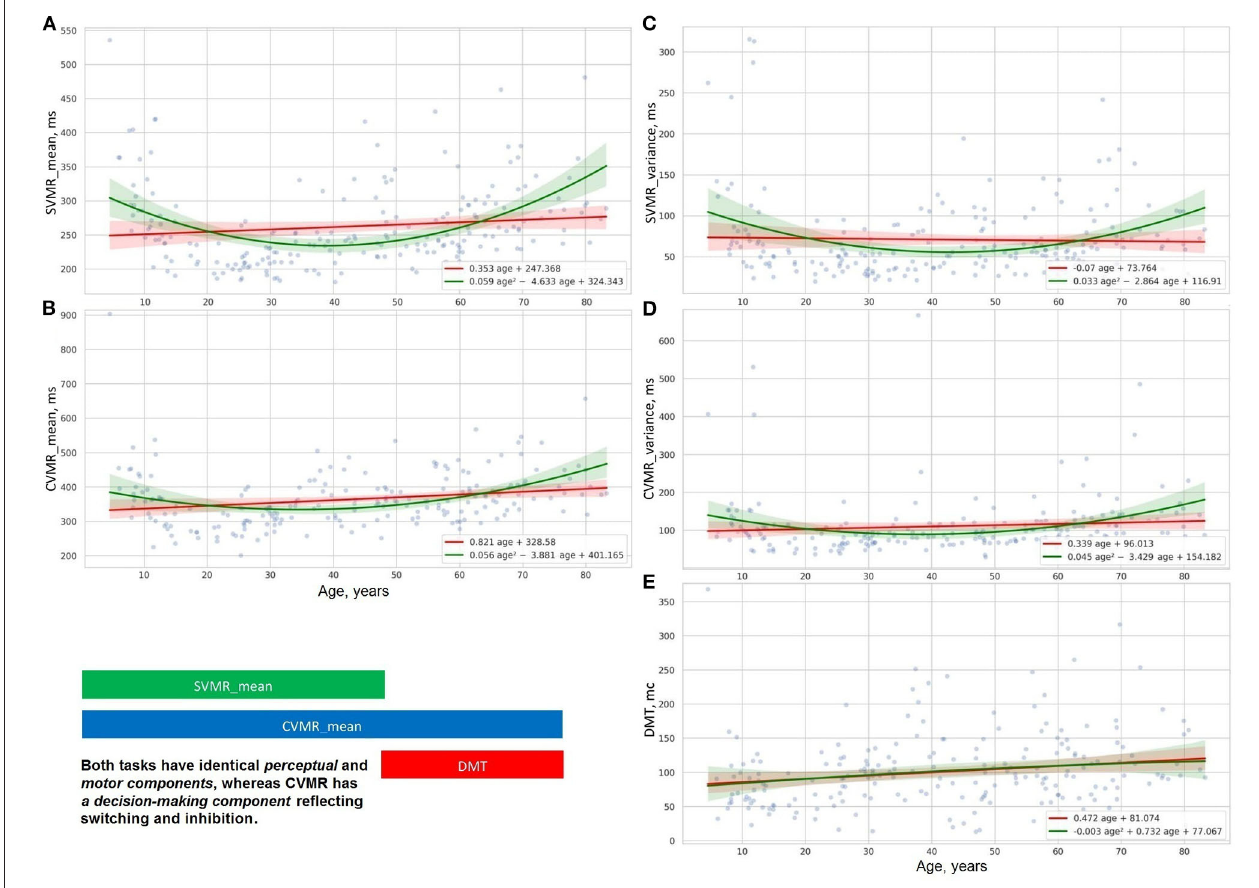
FIGURE 5 | Distribution of decision making (E) , reaction time and its varience in simple (A,C) , and complex (B,D) visual-motor